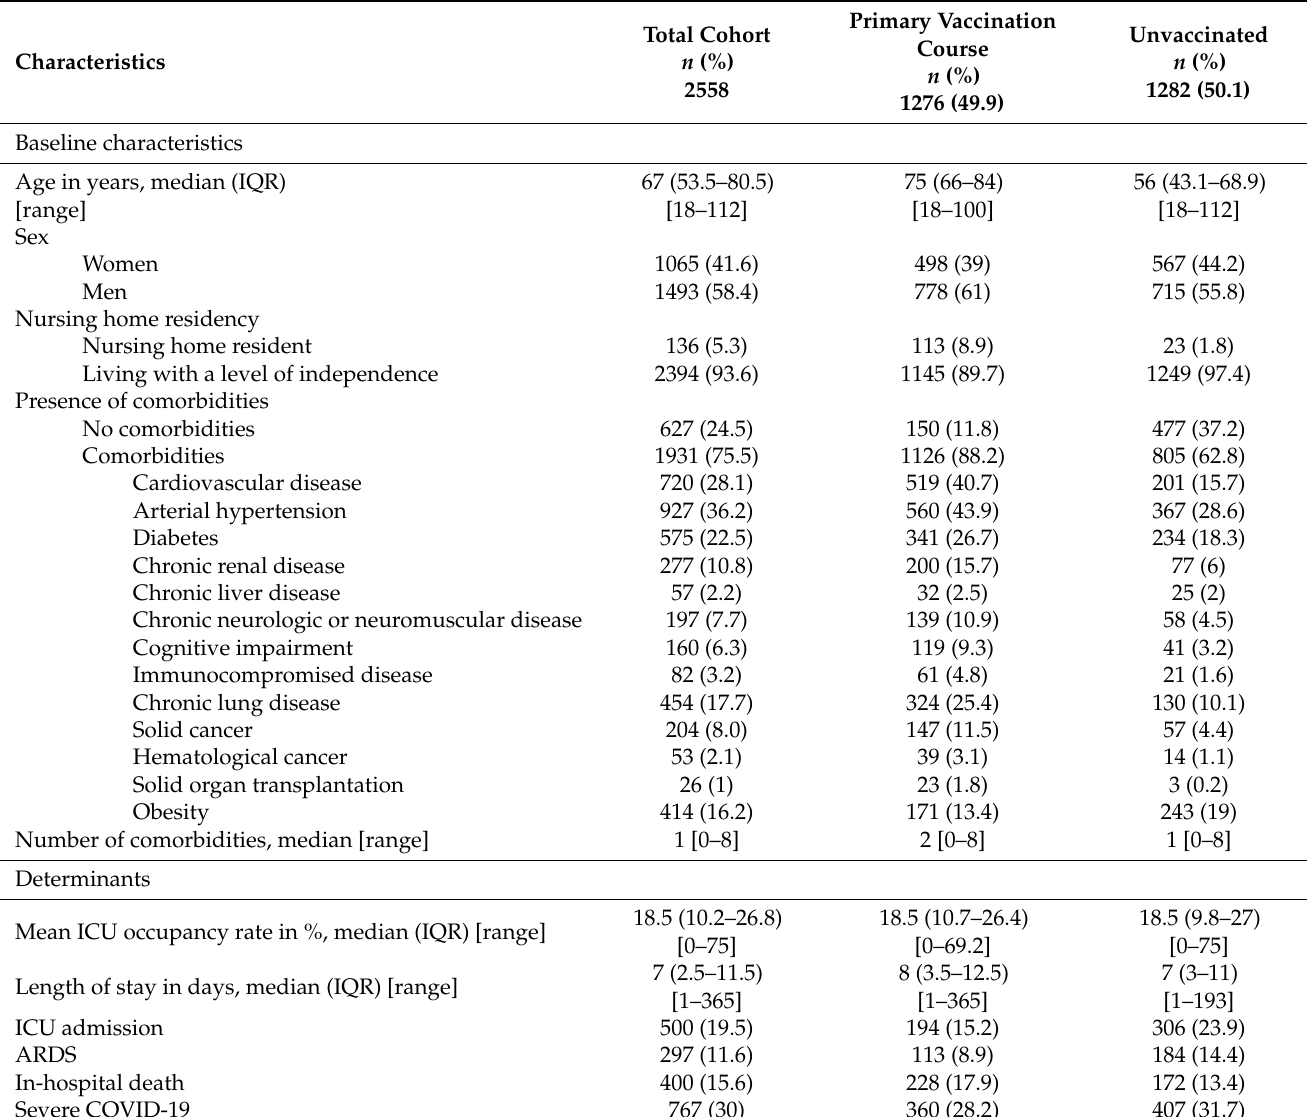
Table A1. Description study population before exclusion of